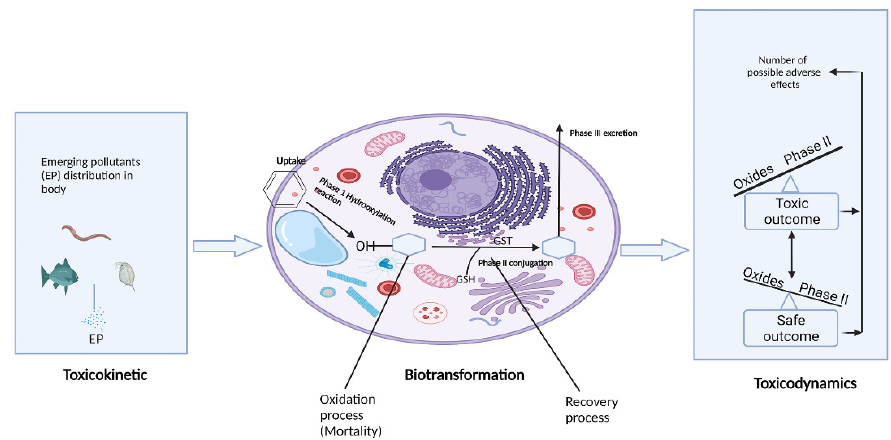
Figure 5. Schematic biotransformation processes result either in toxic or safe products.